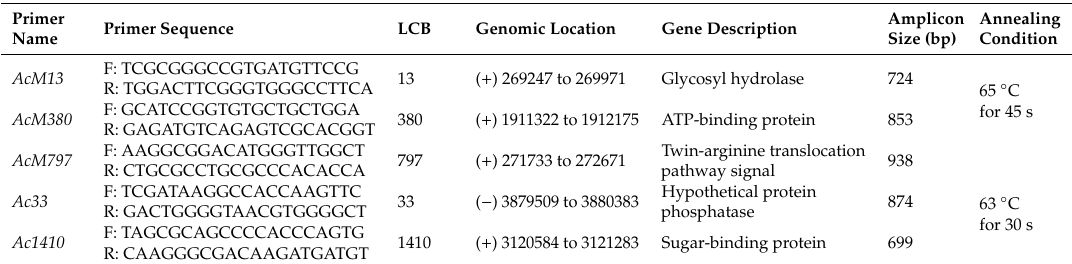
Figure 2. Segments of whole-genome alignment of six A. citrulli strains. Primers AcM13 , AcM380 , and AcM797 were designed from the M6 strain where three segments (red rectangles) that are present only in “ Ac M” strains ( a , b ). A. citrulli specific-primers Ac33 and Ac1410 were designed from the AAC001 strain where two segments (green rectangles) that are present in both “ Ac WM” and “ Ac M” strains ( c , d ). Details of the primers are shown in Table 3. In the Mauve alignment (Mauve tool, version 2.4.0), each genome is laid out horizontally with homologous segments (LCBs) outlined as colored rectangles. Lines collate aligned segments among genomes. Average sequence similarities within an LCBs, measured in sliding windows, are proportional to the heights of interior colored bars. Large Sections of white within blocks and gaps between blocks indicate lineage-specific sequences. Right side in strains name WM and M indicate A. citrulli strains isolated from watermelon and melon hosts, respectively. Table 3. Primer sets designed for detecting A. citrulli strains causing BFB disease via polymerase chain reaction (PCR) assays.